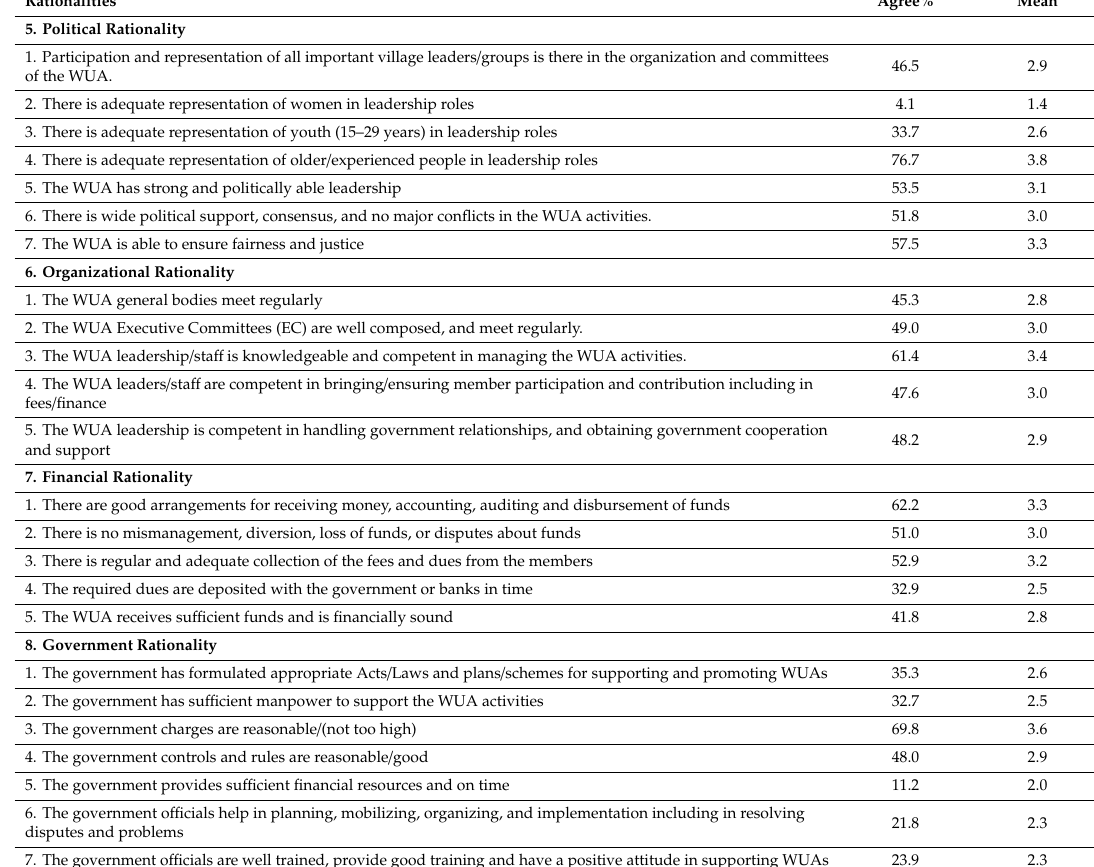
Table 7. Assessment of rationalities—percent